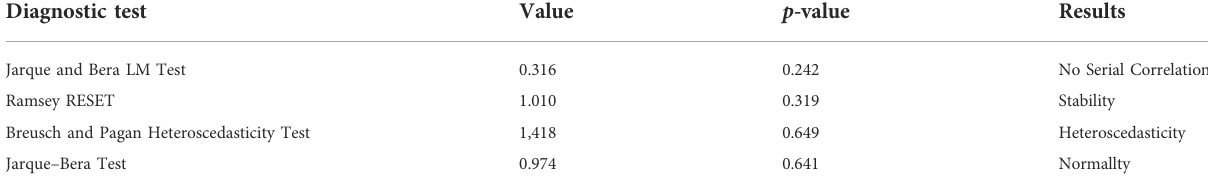
TABLE 7 Diagnostic